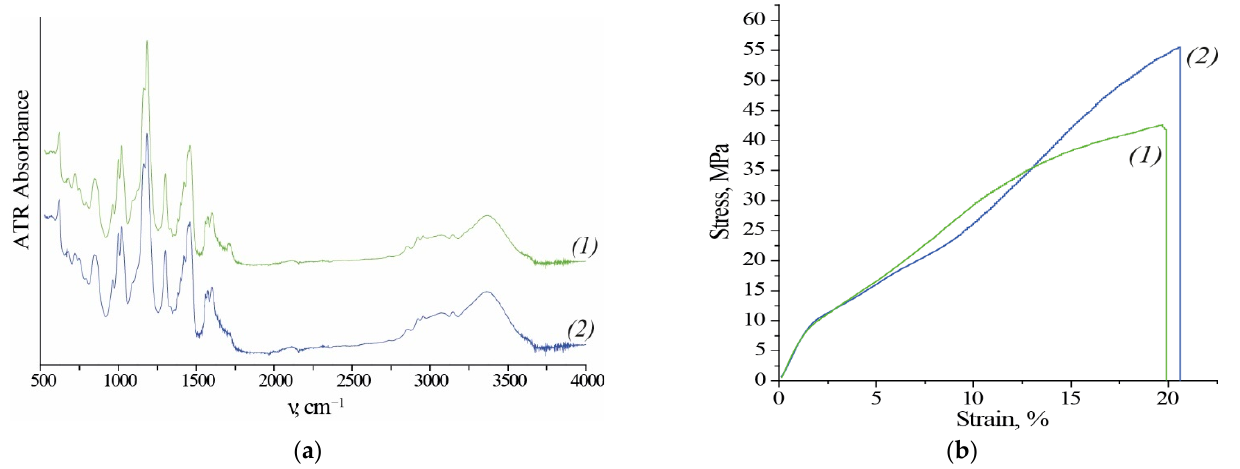
Figure 3. ( a ) Fourier transform infrared spectroscopy (FT-IR) spectra and ( b ) stress-strain curves for membranes (1) before use (initial state) and (2) after use (in a dry state, Cl − form).